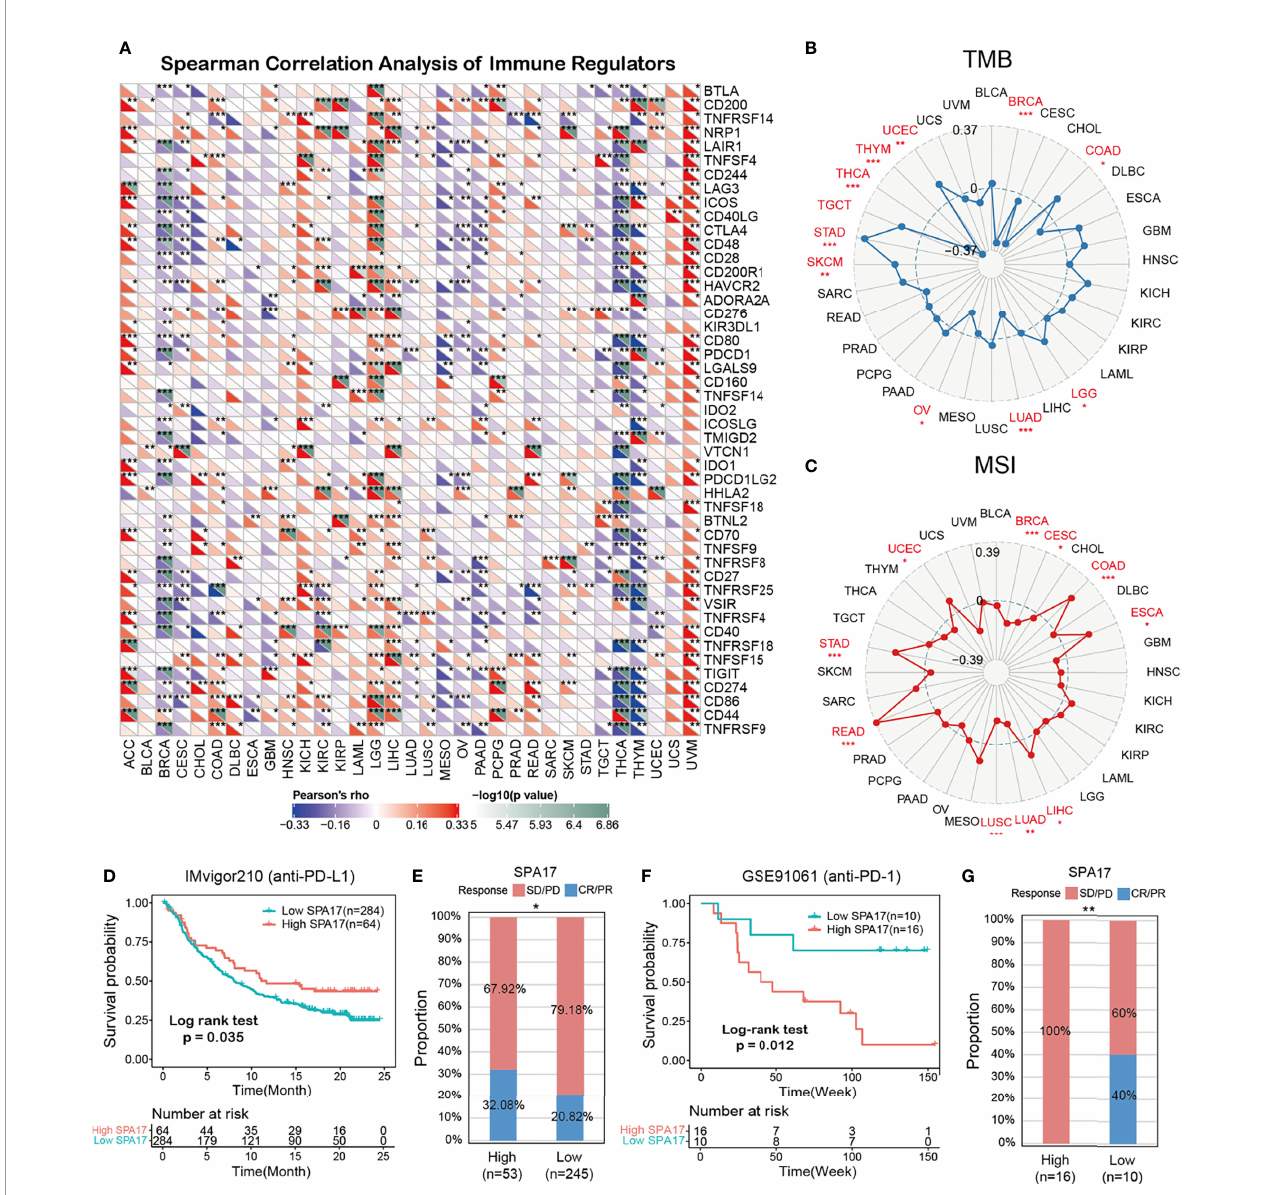
FIGURE 5 | (A) The Spearman correlation heatmap shows the correlation between the expression of SPA17 and 47 kinds of immune regulators in pan-cancer. Red represents positive correlation and blue represents negative correlation. (B) Correlations between SPA17 expression and tumor mutation burden in pan- cancer. (C) Correlations between SPA17 expression and microsatellite instability in pan-cancer. (D) Kaplan-Meier curve of low and high-SPA17 subgroup in IMvigor210 cohort (anti-PD-L1), and the proportion of tumors (including kidney cancer) in the low-SPA17 and high-SPA17 subgroups in the IMvigor210 cohort who responded to PD-1 therapy. (E) Kaplan-Meier curve of GSE91061 (anti-PD-L1 melanoma) in the low and high-SPA17 patient groups, and the proportion of melanoma patients in the GSE91061 low and high-SPA17 subgroups that responded to anti-PD-1 therapy. The labelled asterisk indicated the statistical p-value (*p < 0.05, **p < 0.01, ***p <